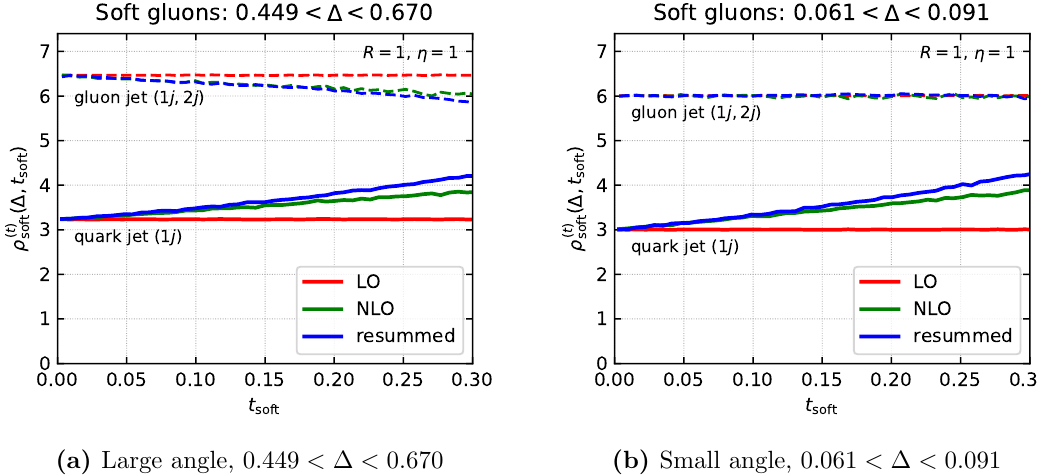
Figure 4. All-order resummation of logarithms from soft-gluon emissions. For both plots, we give the results for a quark con(cid:12)guration (solid lines) and a gluon con(cid:12)guration (dashed lines). LO ( O ( (cid:11) s )) and NLO ( O ( (cid:11) 2 )) results are shown for comparison. For the quark con(cid:12)guration we s have used a (1 j ) dipole connecting the incoming particle ‘ 1 and the outgoing \jet" ‘ j , while for the gluon con(cid:12)guration, we have considered the superposition of 2 dipoles (1 j; 2 j ), i.e. one dipole connecting the incoming ‘ 1 with ‘ j and a second dipole connecting the other incoming parton ‘ 2 with ‘ j (cf.